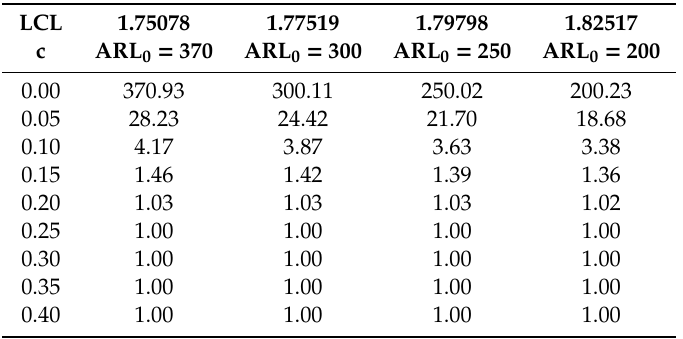
Table 7. The ARLs for the proposed chart when n = 25, GD (9.0,0.45), USL = 8.3602, and LSL = 1.4096.